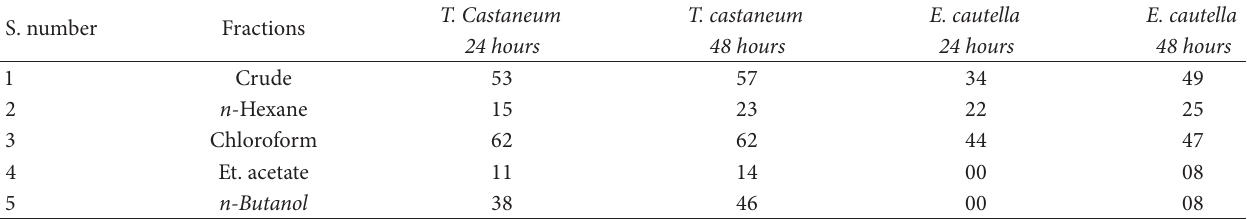
Table 3: Showing percentage mortality rate of insects against different fractions of Oxalis corniculata .